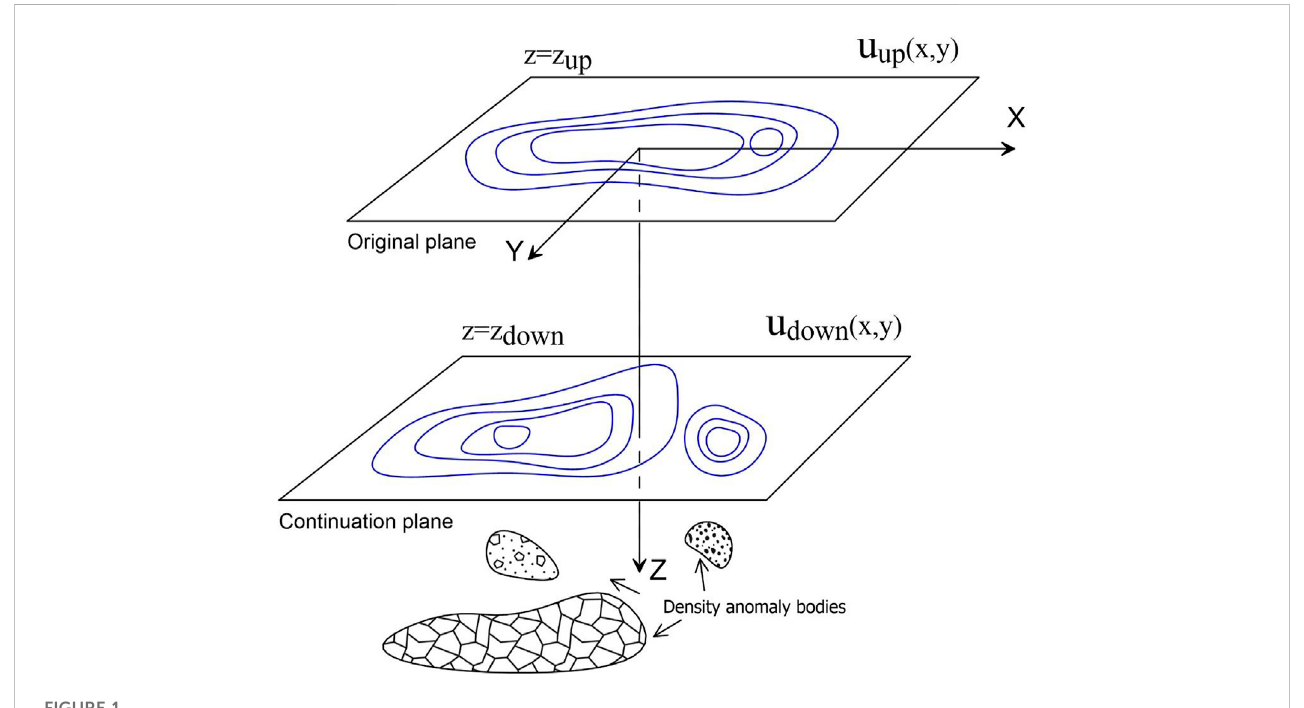
FIGURE 1 Schematic diagram of the DC